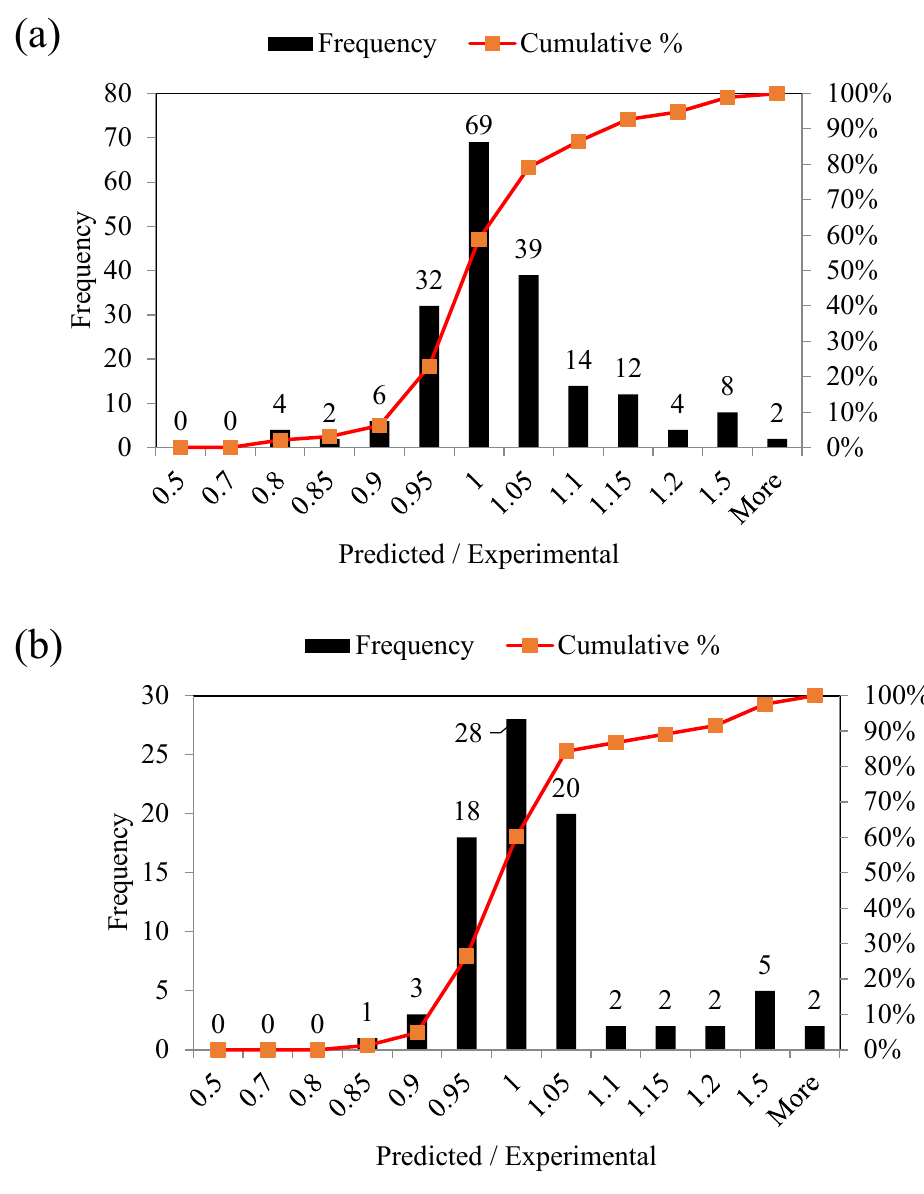
Figure 8. Predicted/experimental ratio for the optimized trial No. 5. ( a ) Training dataset ( b ) Valida- tion dataset